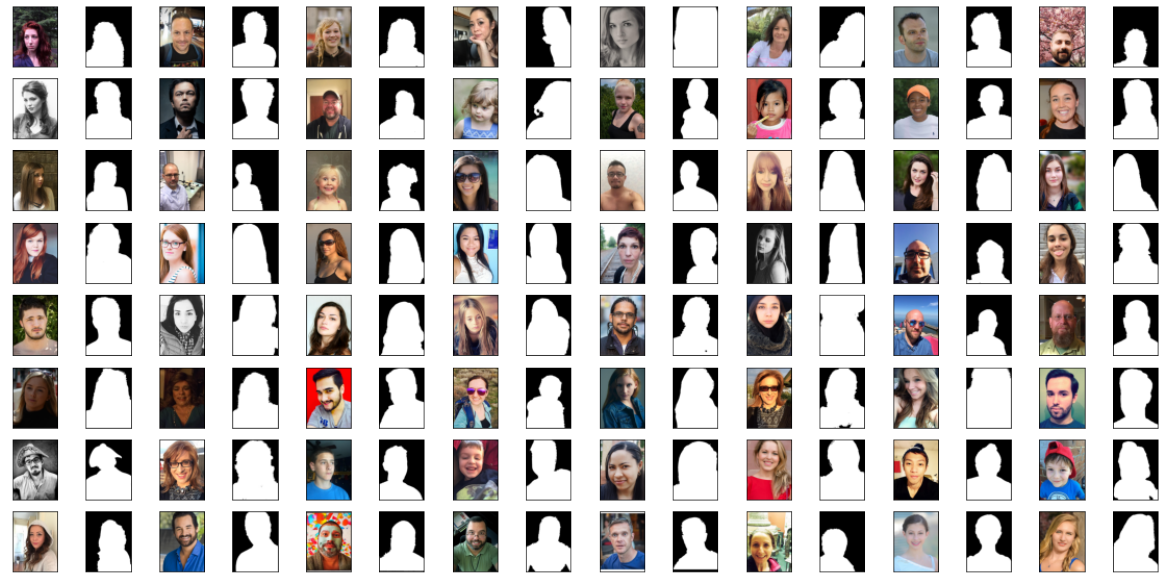
Figure 1. Examples of labeled data.